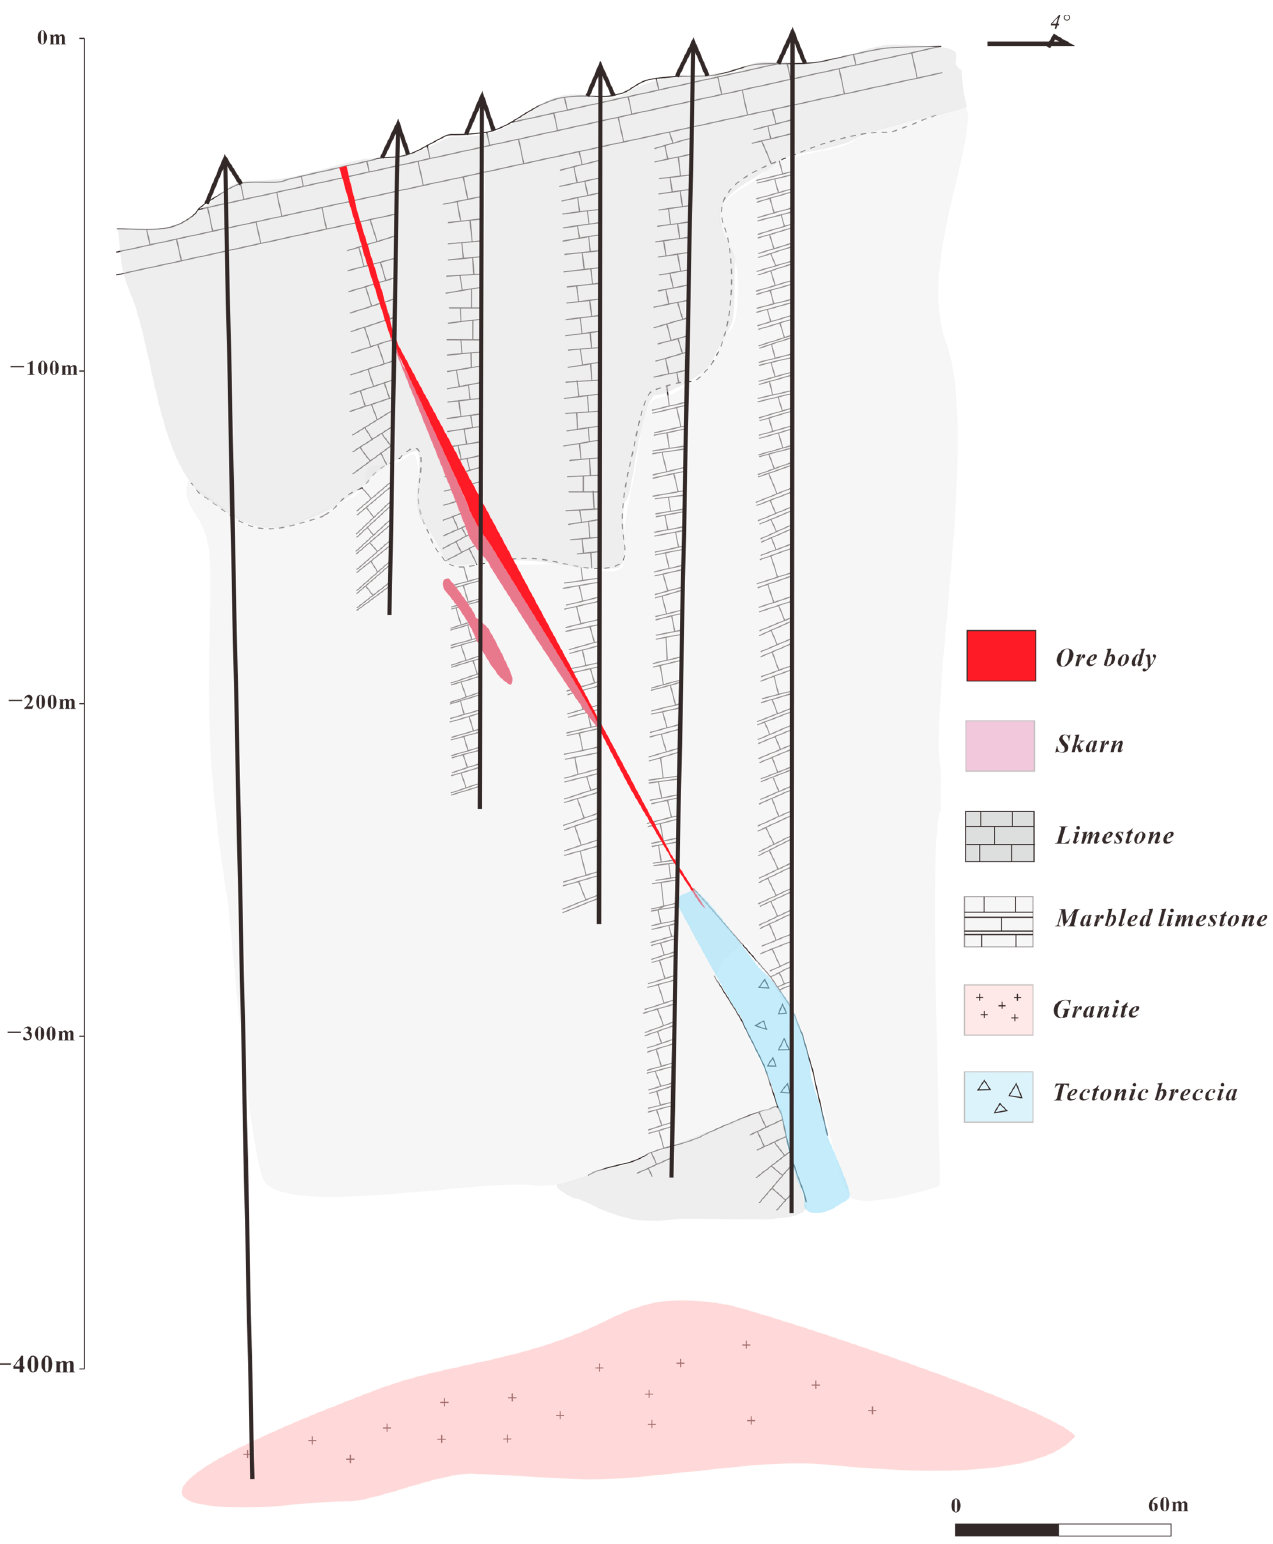
Figure 12. Geological profile of the Suishan zinc deposit in FVB (modified from [166] ). Figure 13. Geological profile of the Suishan zinc deposit in FVB (modified from [166]).